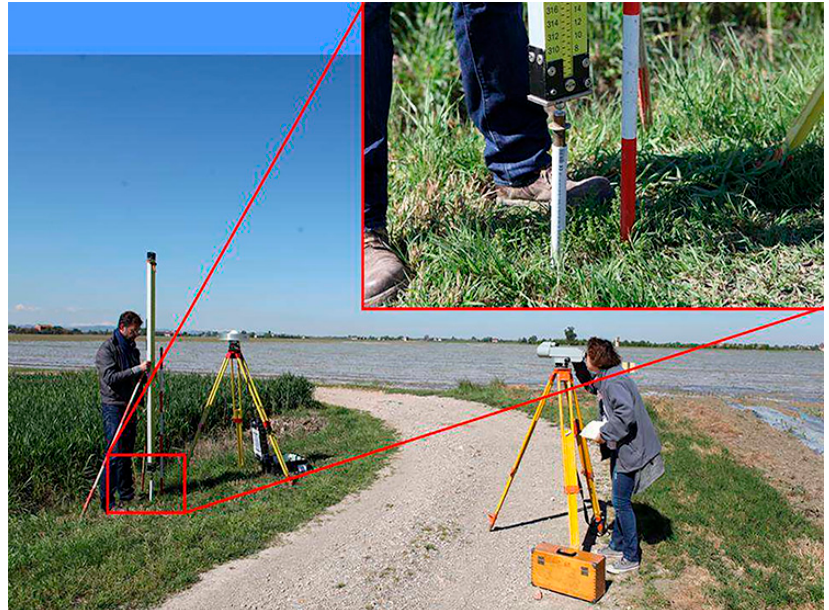
Figure 4. Zeiss Ni1 analogic measurement of the height difference between GNSS-ARP and the South leveling bolt at site Medicina. The inset shows the reference height marker: a bolt on top of a 1.5 m coated metal rod hammered into the ground.